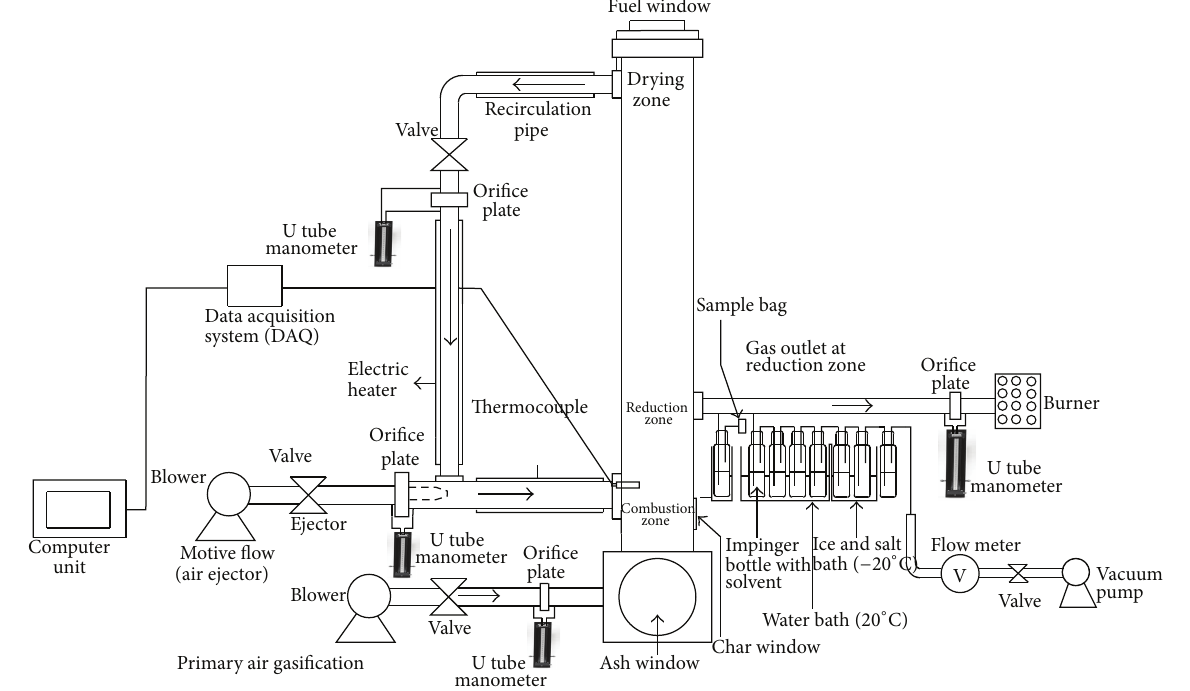
Figure 1: Experimental Setup.